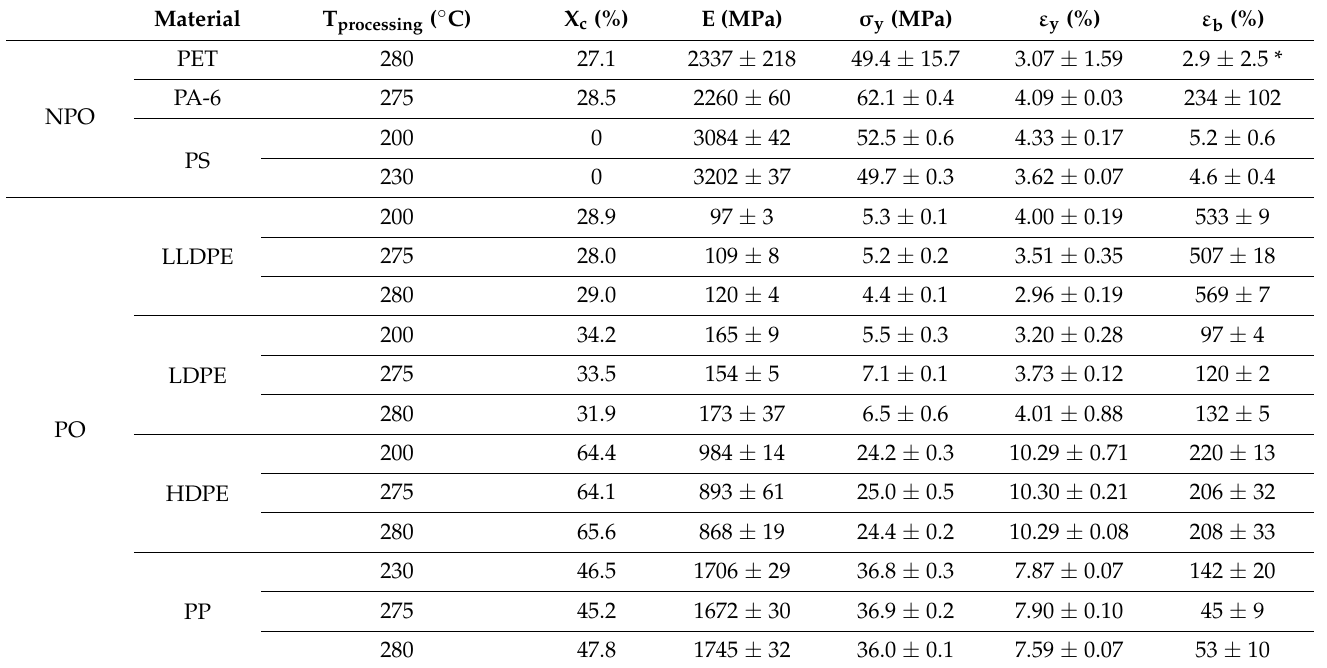
Table 3. Crystallinity and mechanical properties of the materials used, given for each processing